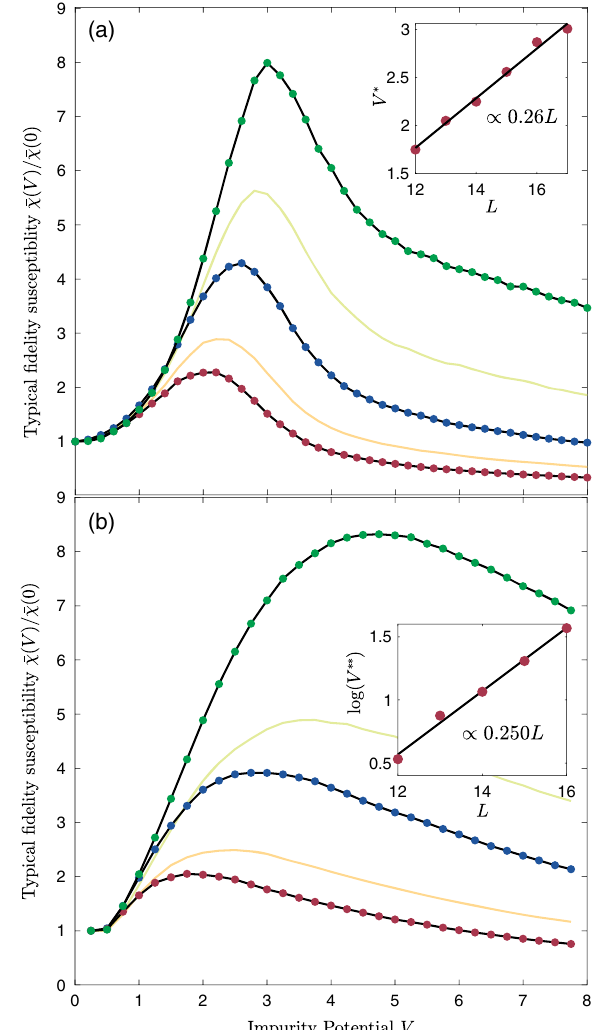
FIG. 9. Typical fidelity susceptibility. (a) and (b) show the typical fidelity susceptibility scaled by its value in the absence of an impurity, i.e., at V ¼ 0 . Different system sizes L ¼ 13 , 15, 17 are shown in red, blue, and green, respectively. In addition, we show L ¼ 14 , 16 in yellow and green, respectively. (a) corre- sponds to the susceptibility of a bulk spin in the full model, whereas (b) shows the susceptibility of the same spin in the effective model. The insets in (a) [(b)] show the scaling of the peak position with system size, together with the best linear (exponential) fit. Physical system sizes corresponding to the full and effective models shown in the same color are identical, but as the impurity spin in the effective model is frozen, its actual system size is reduced by